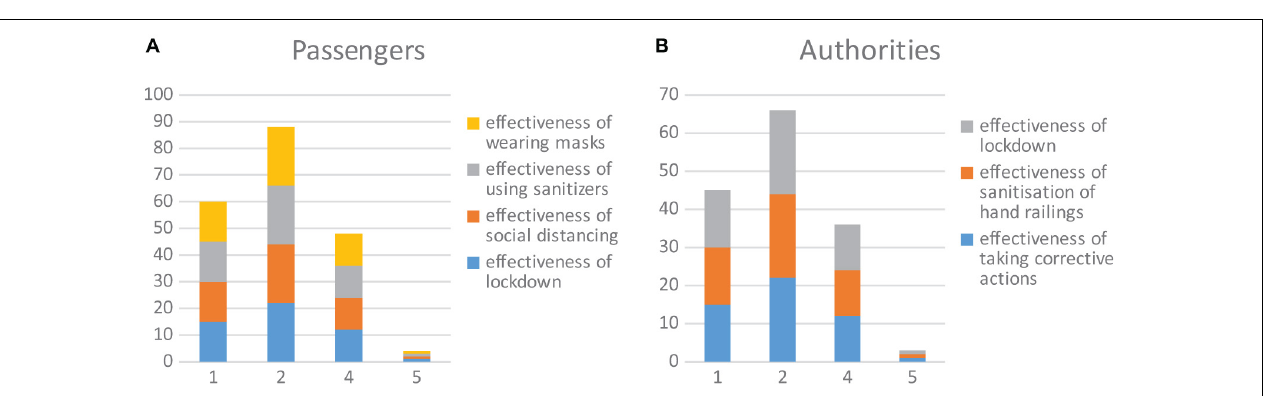
FIGURE 5 | Effectiveness of control measures taken by passengers (A) and authorities (B) of the Wuhan-Beijing railway line.